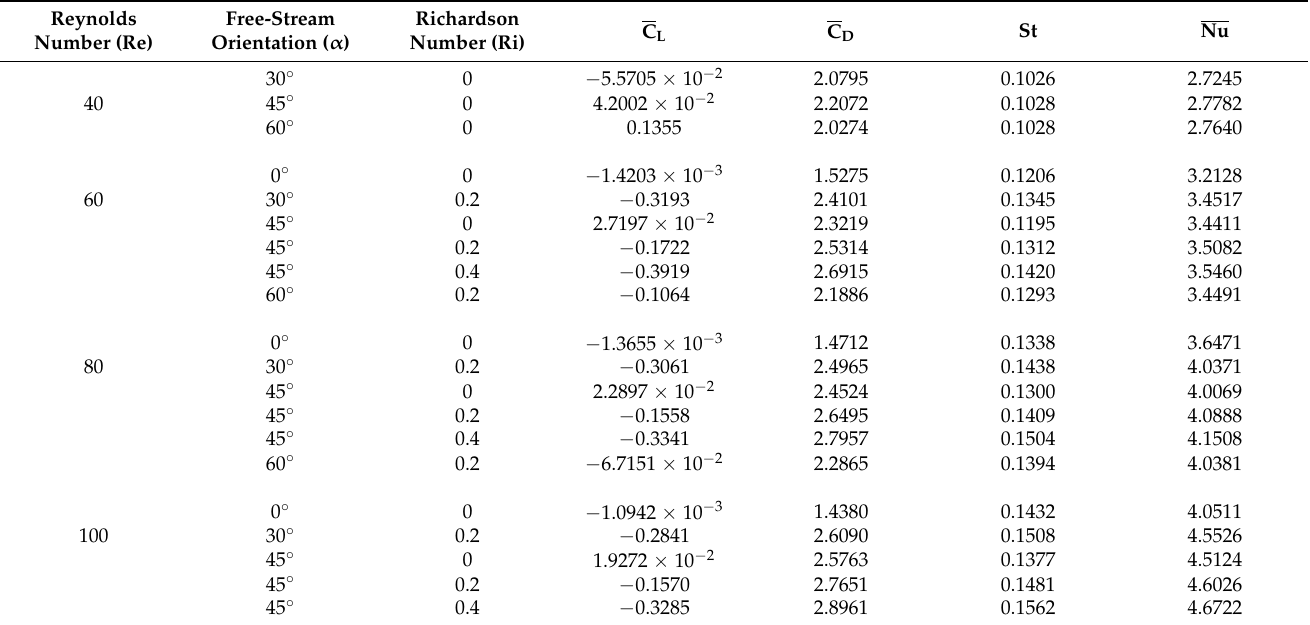
Table 2. Mean lift and drag coefficients, Strouhal number (St) and mean Nusselt number ( Nu ) for